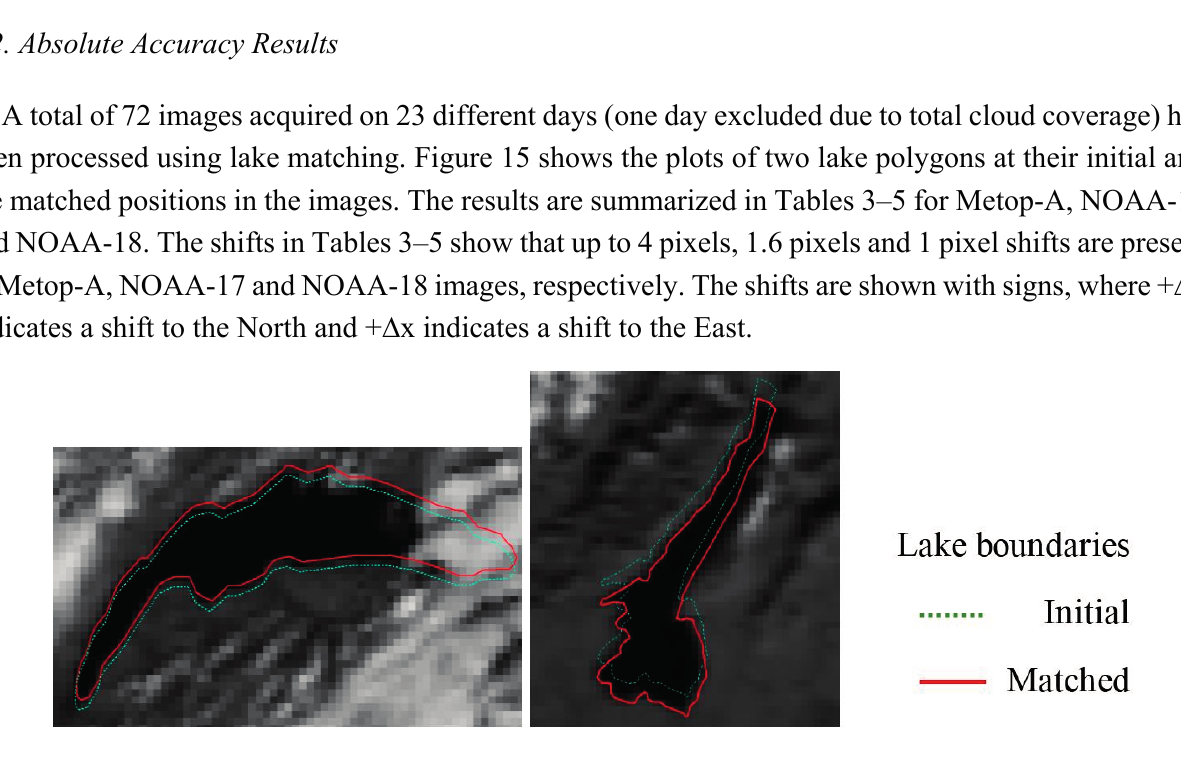
Figure 15. Lake matching results from Lake Leman in a NOAA-17 image ( left ) and Lake Garda in a Metop-A image ( right ). The green polygons represent the initial positions of the lake points and the red polygons represent the matched